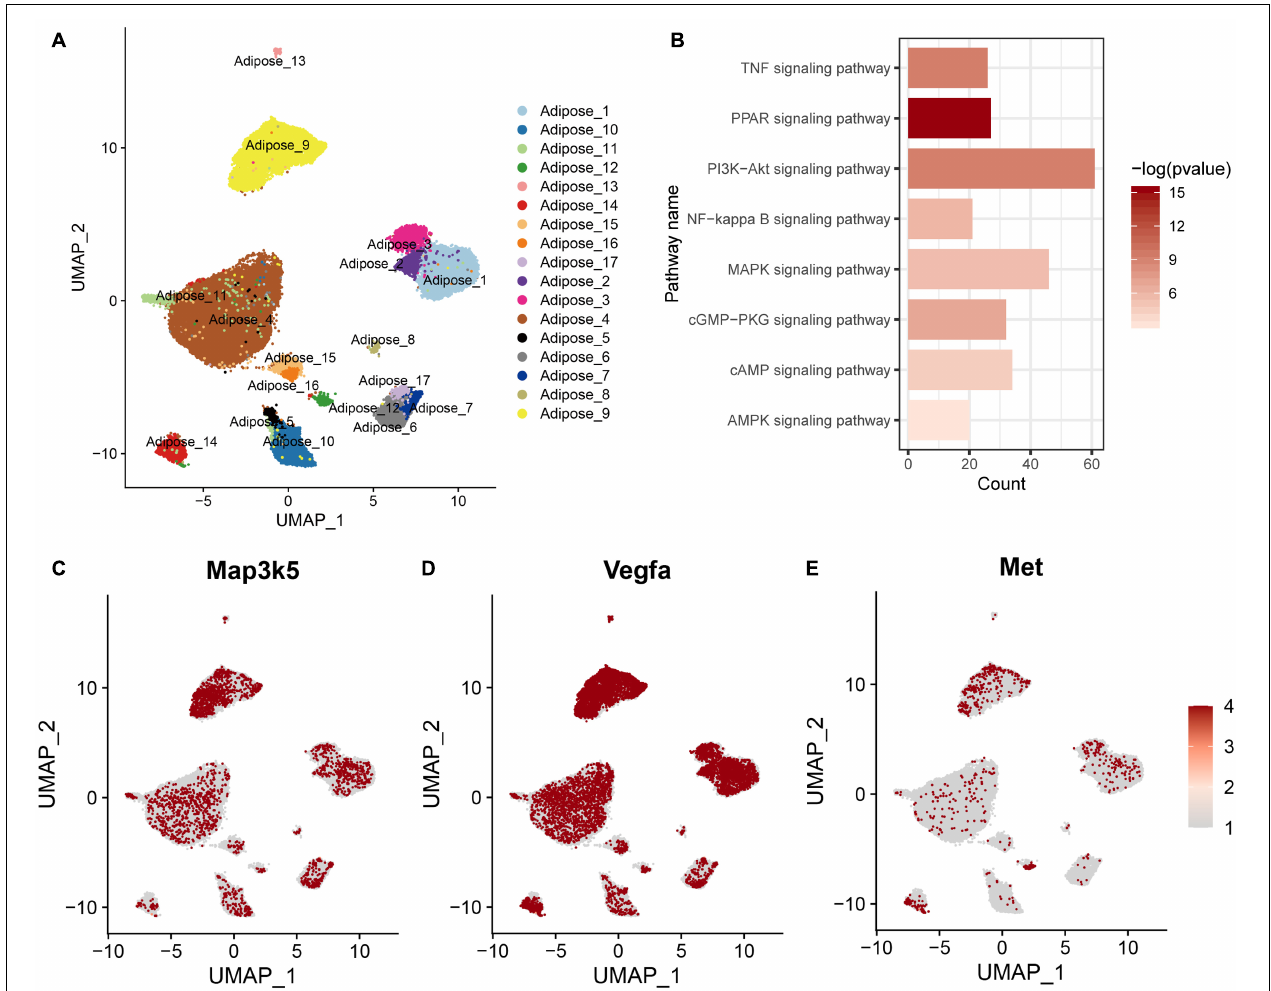
FIGURE 4 | Gene expression and the related KEGG pathway in metabolic active adipocyte subtype by single-nuclei RNA sequencing. (A) UMAP plot of single-nuclei RNA sequencing data (GSE133486) illustrating the cell types of adipocytes. (B) KEGG pathway enriched by the top 2000 variable genes from the metabolic active adipocyte subtype. (C–E) Scaled expression levels of the Map3k5 , Met , and Vegfa genes in the adipocyte subtype depicted using a red gradient (gray denotes a lack of